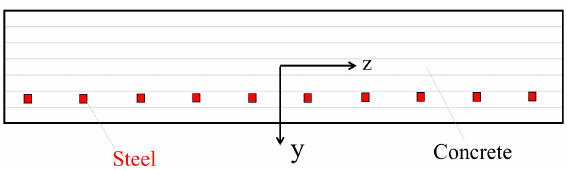
Figure 6. Cross section discretization of the beam multi fiber finite element. The diameter sizes of the steel reinforcements are know- ingly